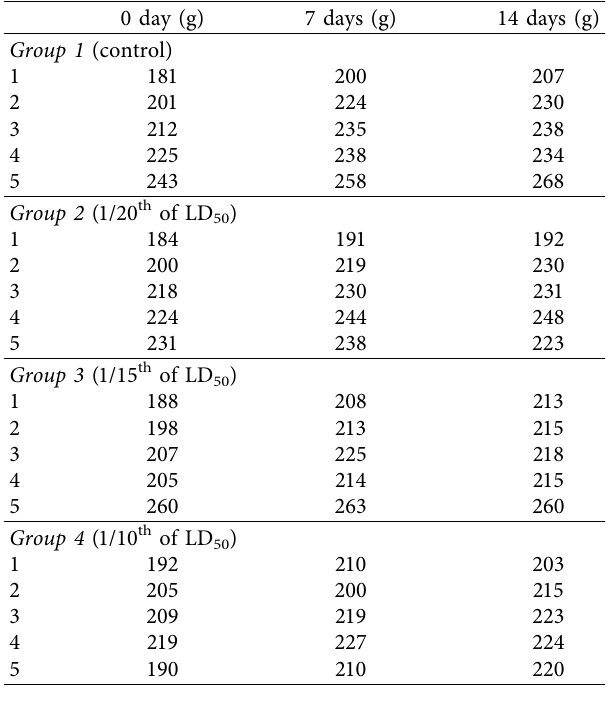
Table 2: Results of LD 50 experiment according to the Spear- man–K¨arber equation.